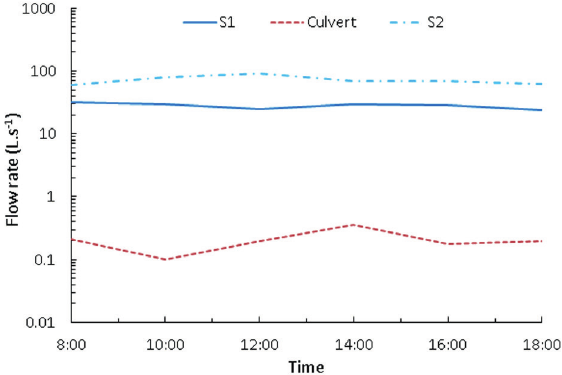
Figure 5 - Hourly variation of flow rates measured in November 14, 2013 (dry season) at S1 and S2, and at a culvert between these two cross-sections.